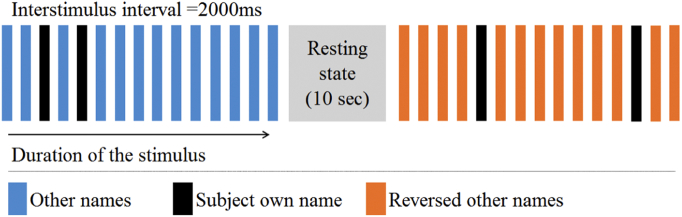
Auditory paradigm, each activation block lasted for 35.5 s, 15 stimuli per block with the random presentation of two SONs and 13 other stimuli or reversed names, in total 22 blocks were presented, 11 with the other names and 11 with reversed names.